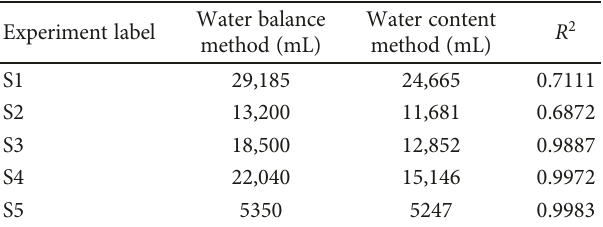
Table 5: Accumulated in fi ltration of di ff erent methods at di ff erent